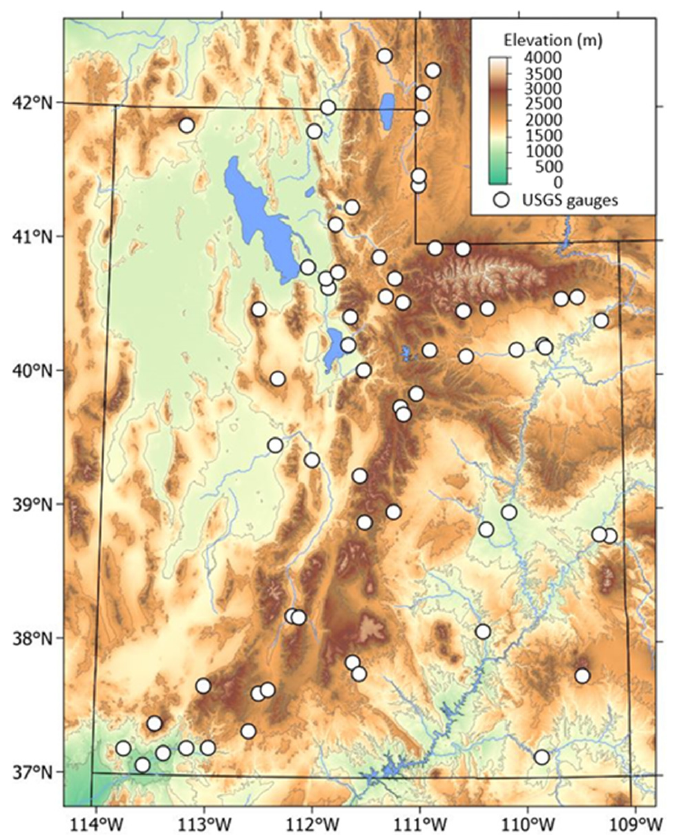
Figure A1. Topographic map of Utah and surrounding areas with larger lakes and streams and USGS gauges used in this study.